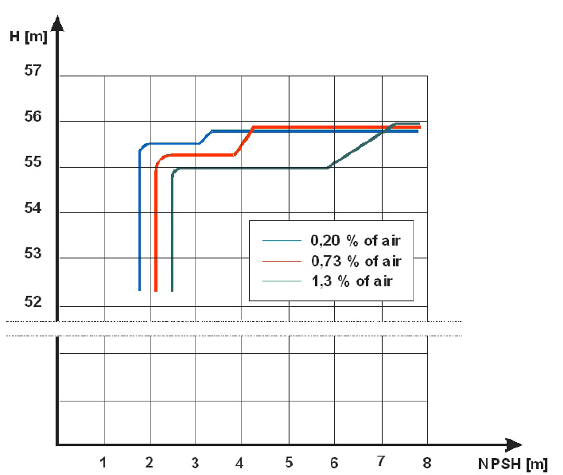
Figure 4. NPSH characteristics during pump aeration [5].